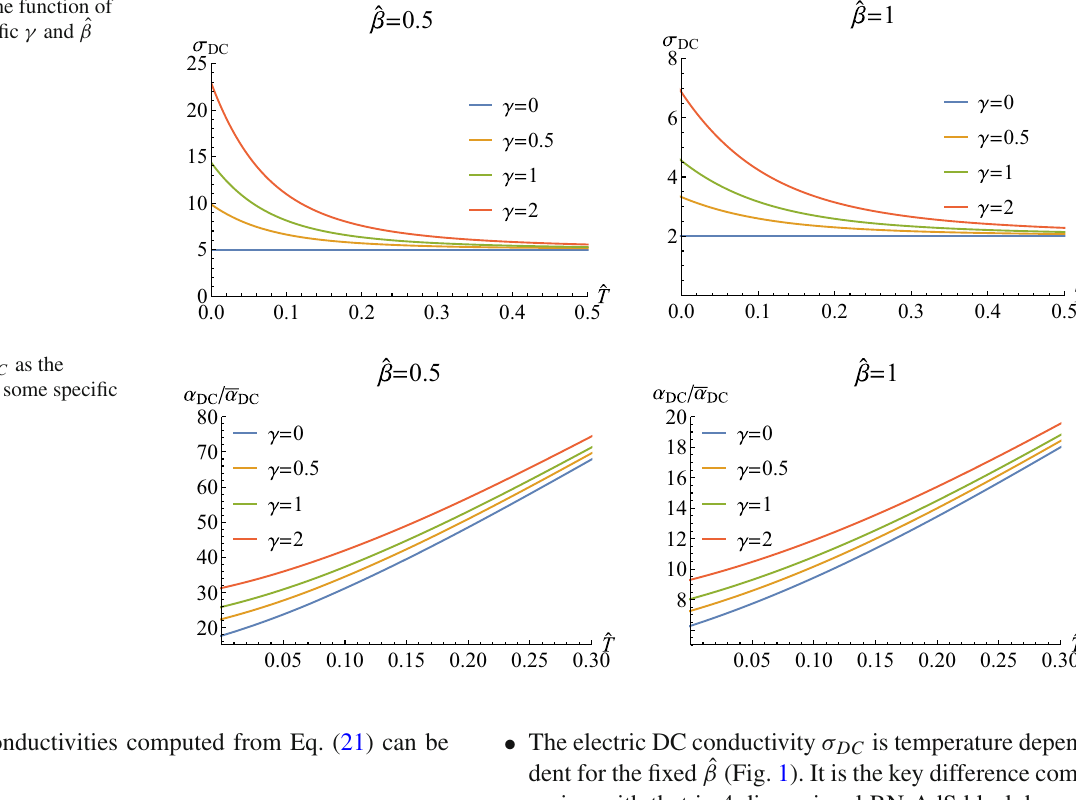
Fig. 1 σ DC as the function of ˆ T for some specific γ and ˆ β